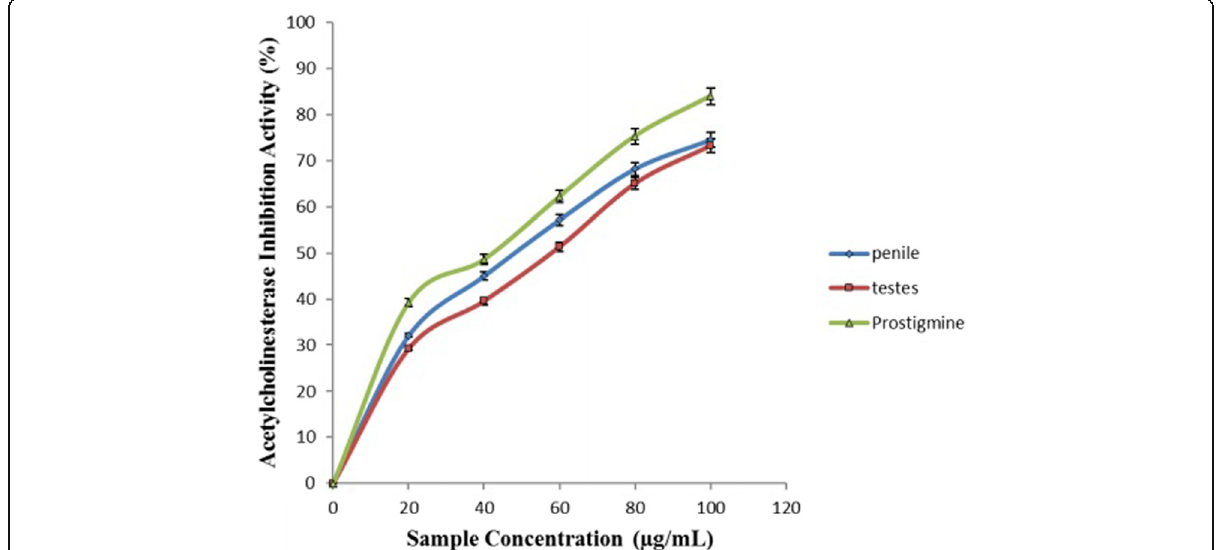
Fig. 3 Inhibition of Acetylcholinesterase activity in rats ’ genitals by aqueous extract from Ocimum gratissimum leaves